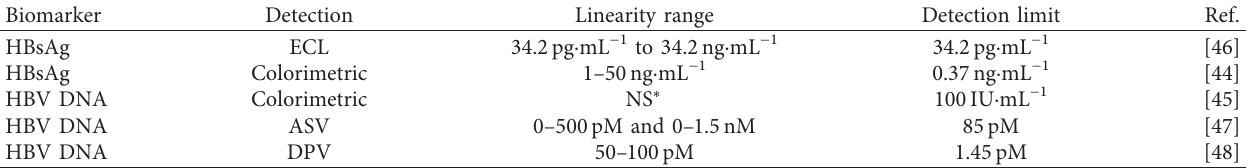
Table 6: Paper-based analytical devices (PADs) with various detections for HBV detection.